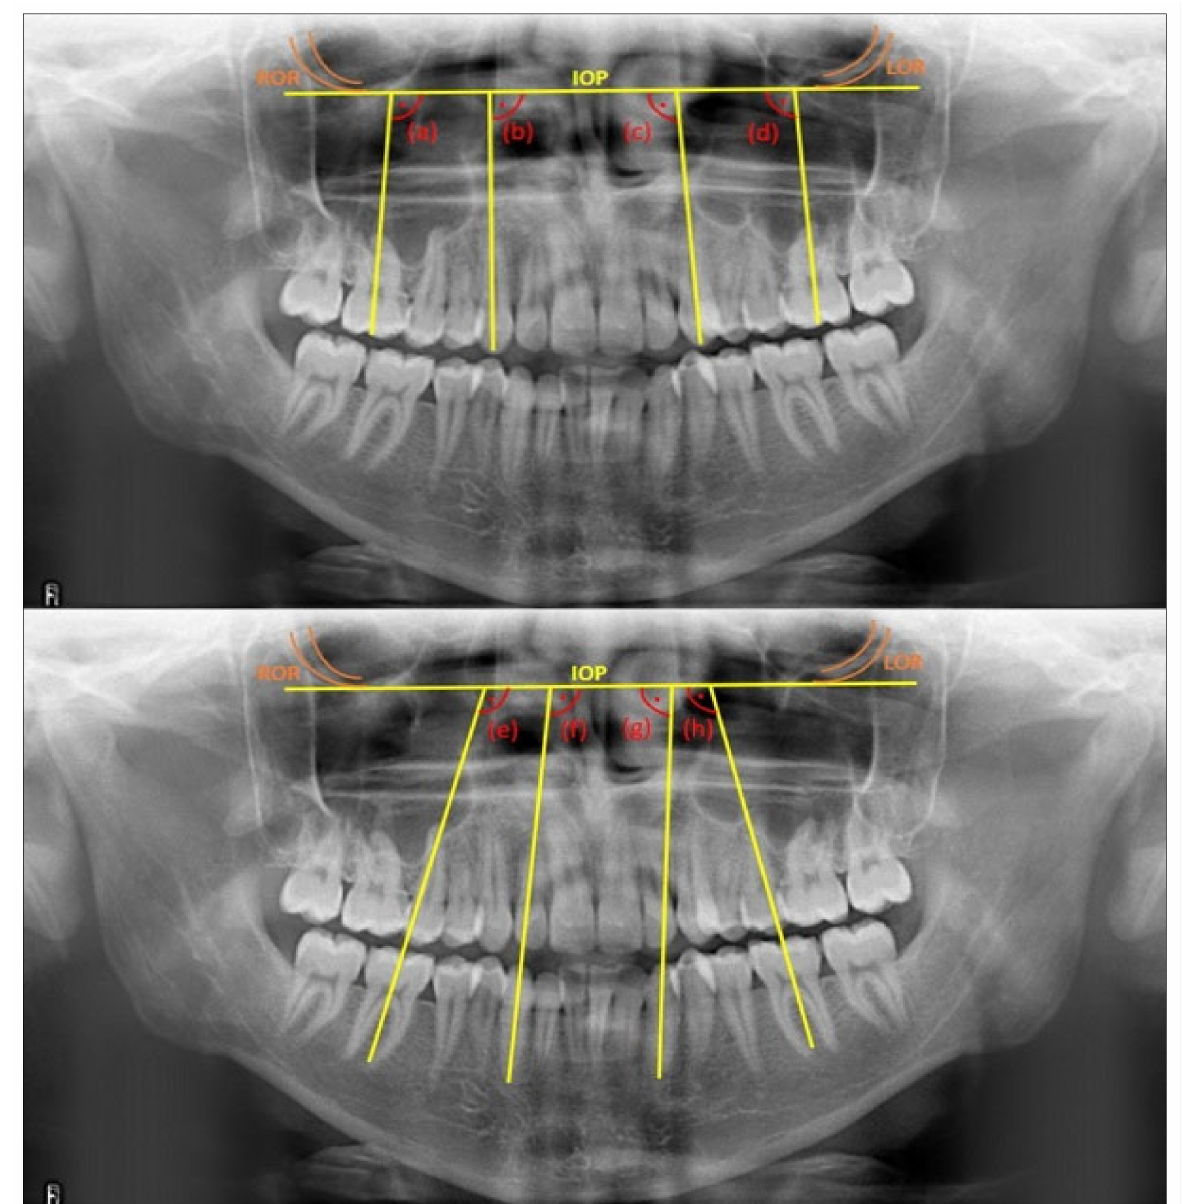
Figure 1. Mesiodistal axial angulation angles measured in the study: (a) for tooth 16, (b) for tooth 13, (c) for tooth 23, (d) for tooth 26, (e) for tooth 46, (f) for tooth 43, (g) for tooth 33, and (h) for tooth 36. ROR: right orbital rim; LOR: left orbital rim; IOP: interorbital